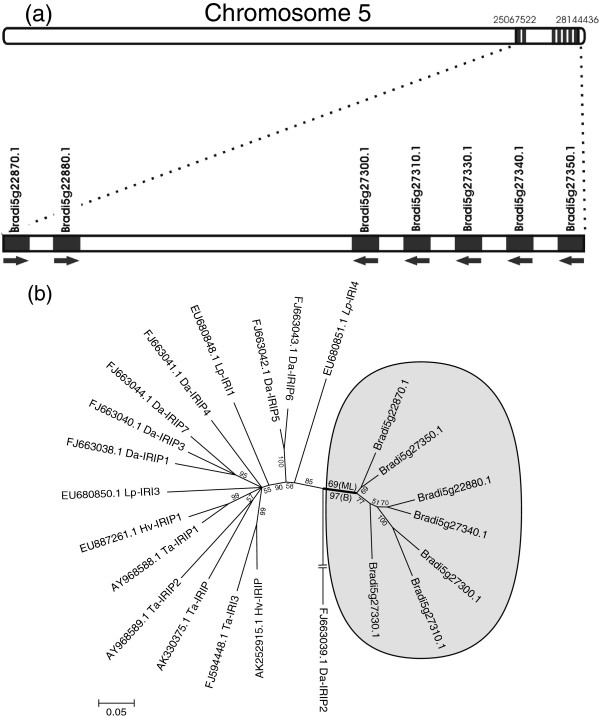
Localization and distribution of seven IRIP genes identified in Brachypodium distachyon on chromosome 5 and B. distachyon IRIP genes phylogeny. (a) The location of seven Brachypodium distachyon IRIP genes on chromosome 5. (b) 50% consensus ML phylogeny (model J2 + G) of a subset of IRIP sequences from core Pooideae species and all 7 B. distachyon IRIP homologs based on 100 bootstrap replicates. The clade support from the alternative Bayesian phylogeny (1.000.000 generations) is shown together with the ML bootstrap support at the split which defines B. distachyon IRIP genes as monophyletic. Species abbreviations are as follows: Lp, Lolium perenne; Da, Deschampsia antarctica; Hv, Hordeum vulgare; Ta, Triticum aestivum.